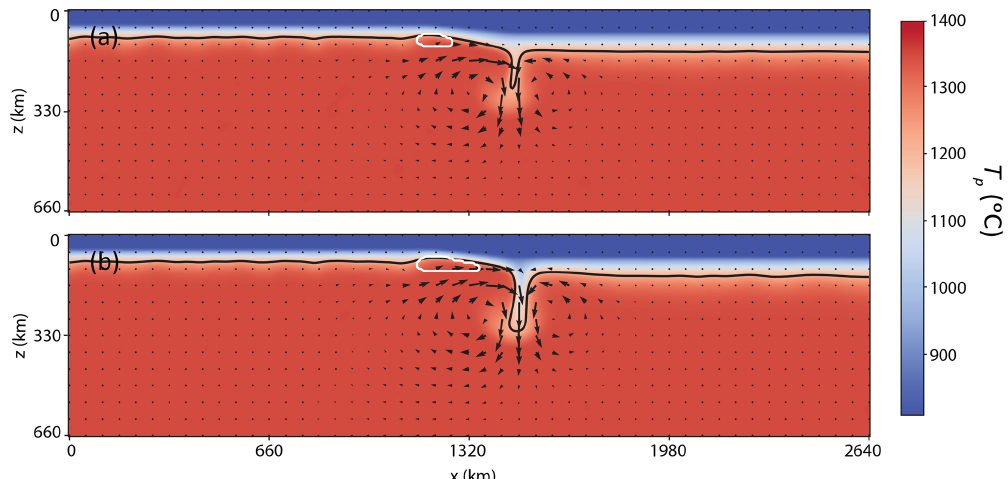
Figure B2. Model snapshots of mantle flow and melting for a case with composition-dependent rheology (a) and a case without composition- dependent rheology (b) . Physical properties as in the case with maximum melting in Fig. 6 ( η 0 = 2 . 87 × 10 18 Pas; E a = 120kJmol − 1 ). Note that although the velocity fields are very similar, the case with rheological stabilization (a) shows less erosion at the base of the lithosphere than the case without (b) , resulting in less vigorous upwellings and downwellings. Consequently, melting rates are also lower for the cases with composition-dependent rheology (compare the white contour of panel of a with that of b ).